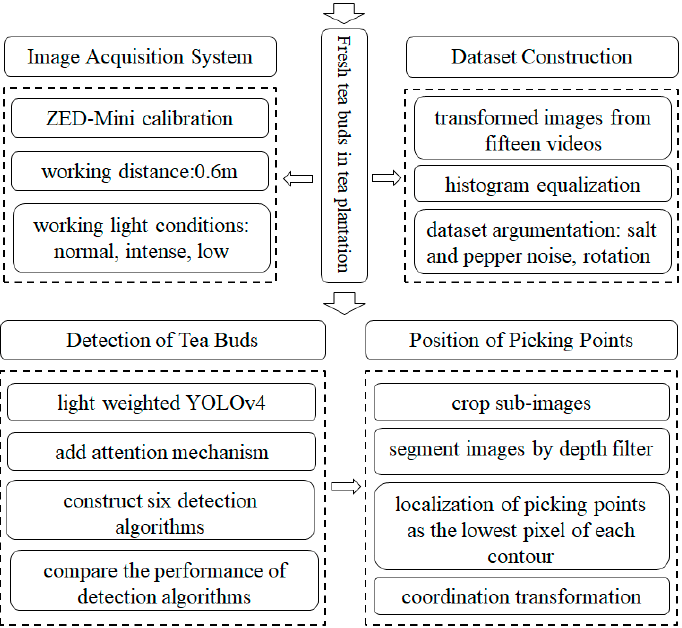
Figure 6. Flow chart of methodology.